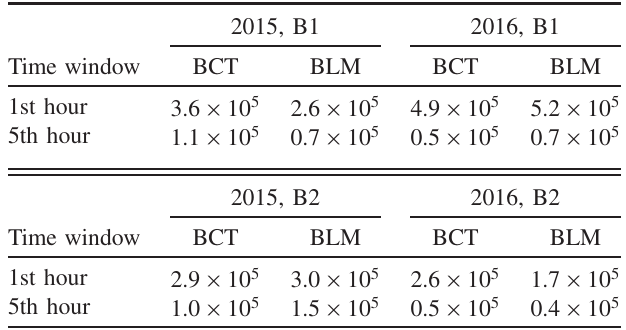
TABLE III. Average beam loss rates, as obtained from the BLM and BCT data shown in Fig. 6, during physics operation in 2015 and 2016. Rates are given in units of protons/s/bunch for the first and fifth hour of collisions.